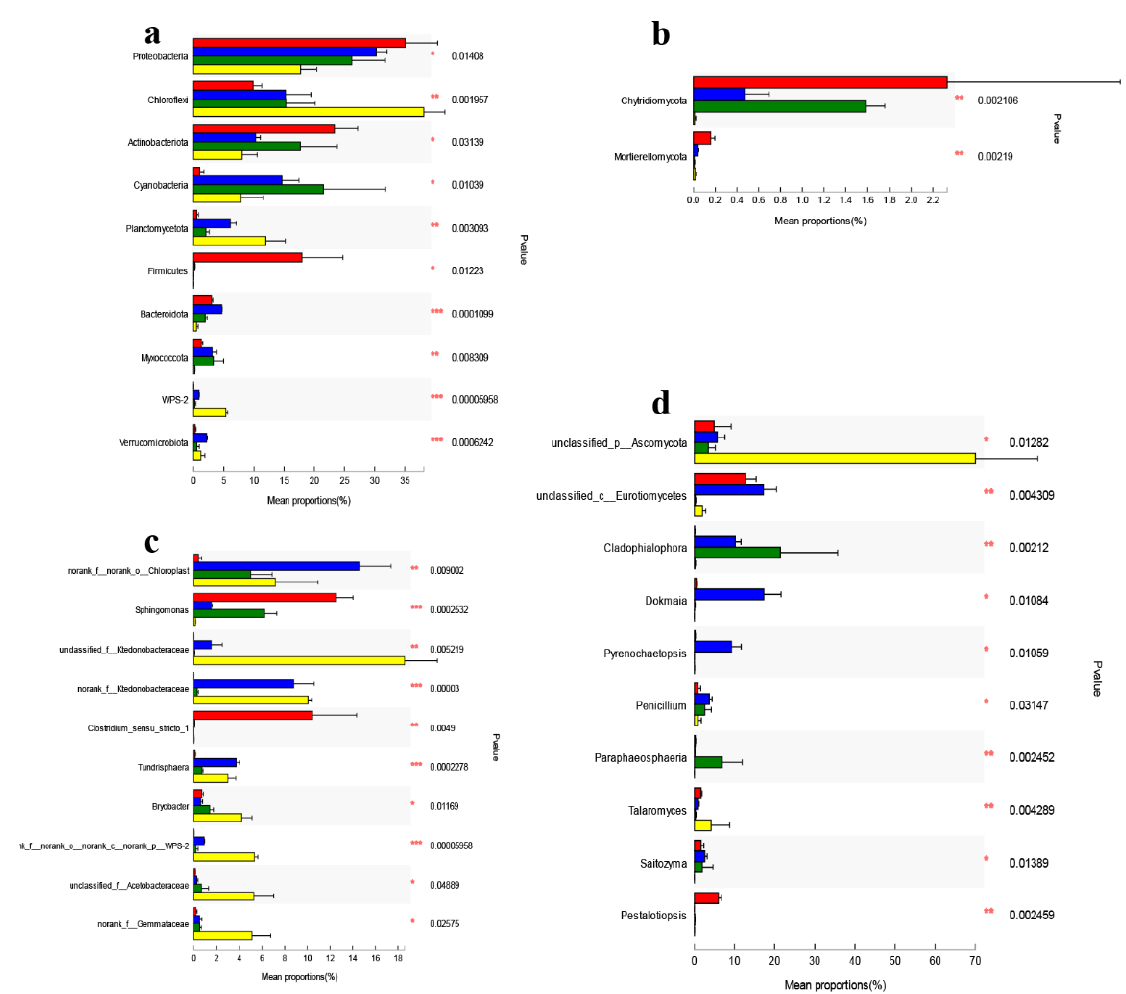
Figure 6. Differential abundance of bacterial or fungal OTUs in moss-dominated biocrusts soils. Welch’s t -tests followed by Bonferroni corrections were performed from Claopodium rugulosifolium , Orthotrichum courtoisii , Polytrichum formosum , and Taxiphyllum giraldii soil at phylum ( a , b ) and genus ( c , d ) levels. Only differentially abundant phyla and genus are shown. The left histogram plots show bacteria abundance difference and the right for fungi. Statistically significant differences (* p < 0.05, ** p < 0.01, *** p < 0.001) were determined by one-way ANOVA followed by post hoc Tukey test. Red color was assigned to Claopodium rugulosifolium soil; cyan to Orthotrichum courtoisii soil; green to Polytrichum formosum soil yellow to Taxiphyllum giraldii